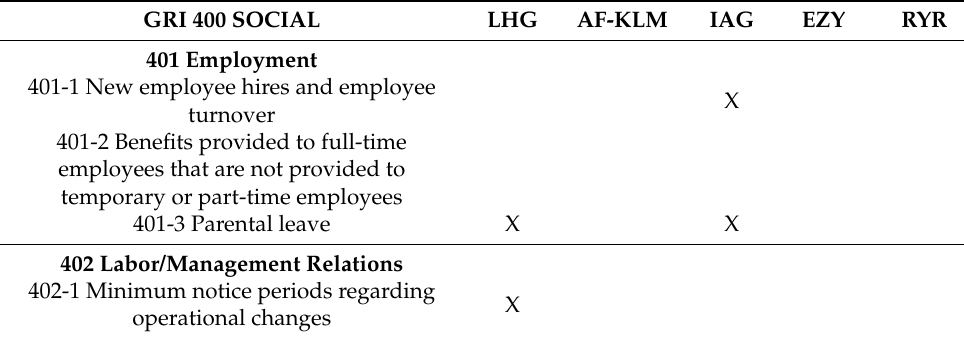
Table 5. Reported disclosures within GRI 400